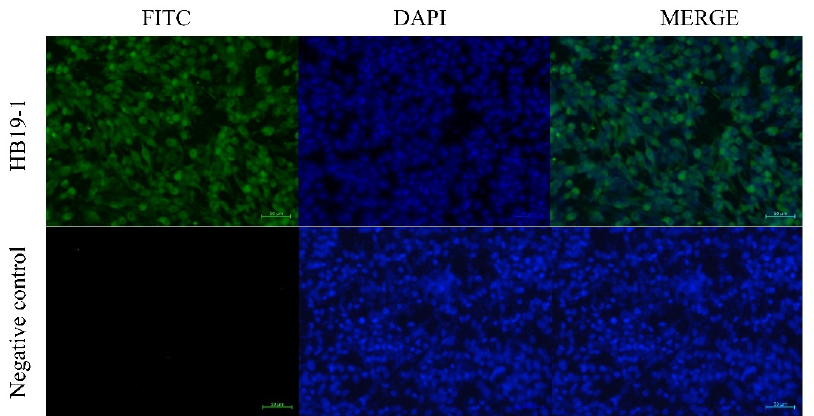
Figure 5. BHK-21 cells inoculated with tissues obtained from HB19-1-infected ICR mice showed many BEV-positive cells by IFA at 36 hpi.